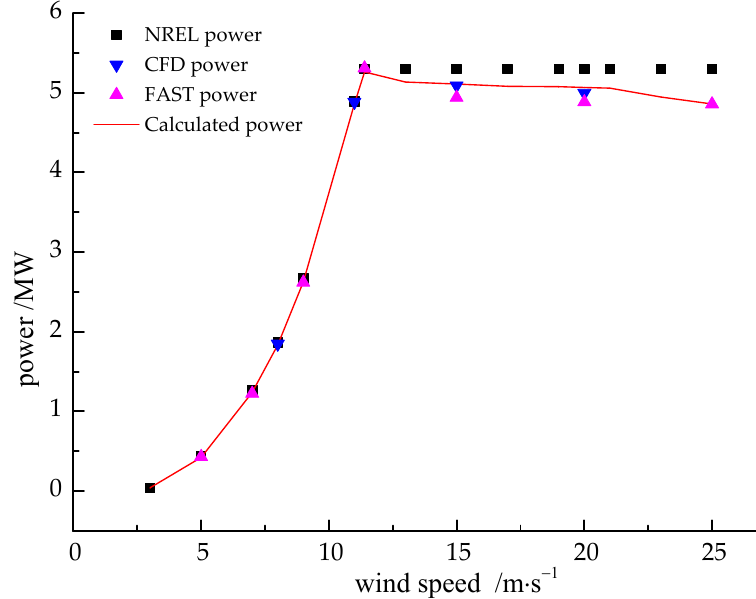
Figure 7. The power of the wind rotor in the lack of coupling of the control system.